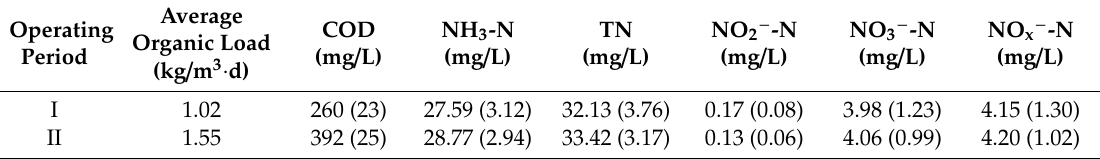
Table 1. Concentration ranges of various pollutants of the synthetic